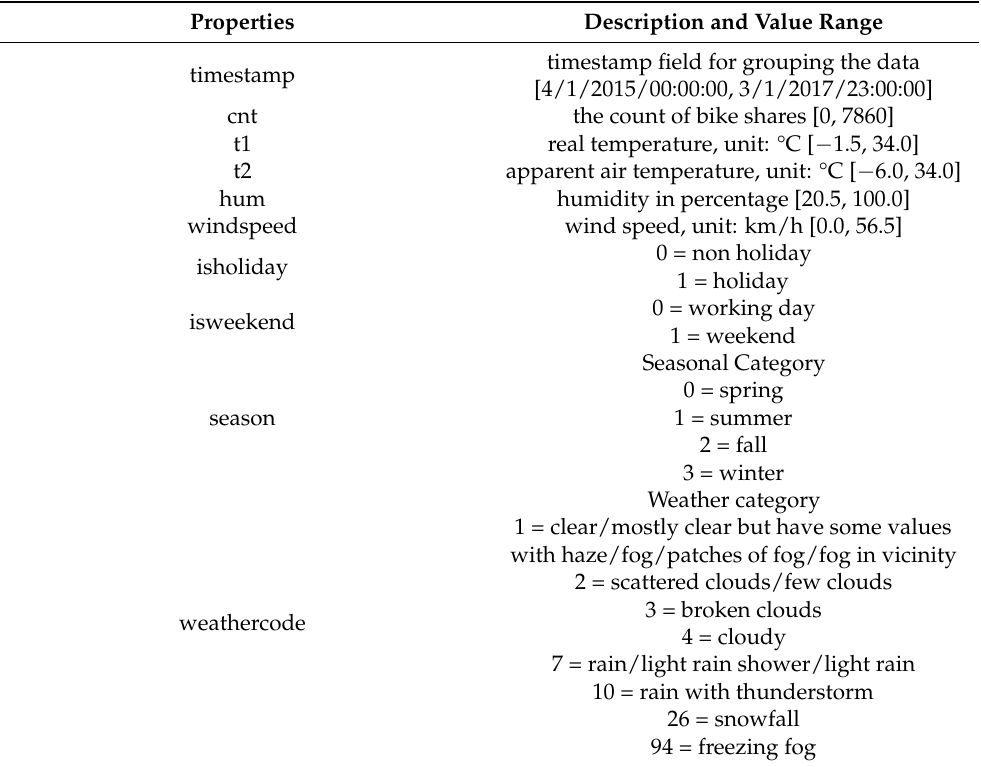
Table 1. Properties description of data